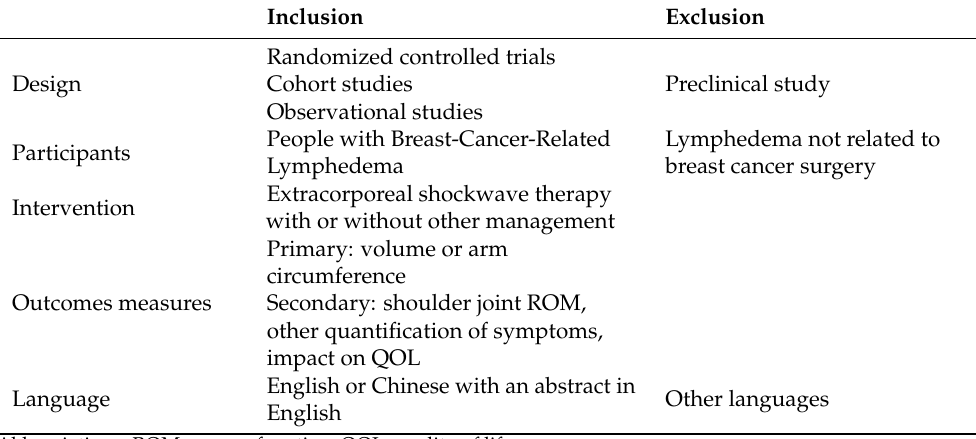
Table 1. Inclusion and exclusion